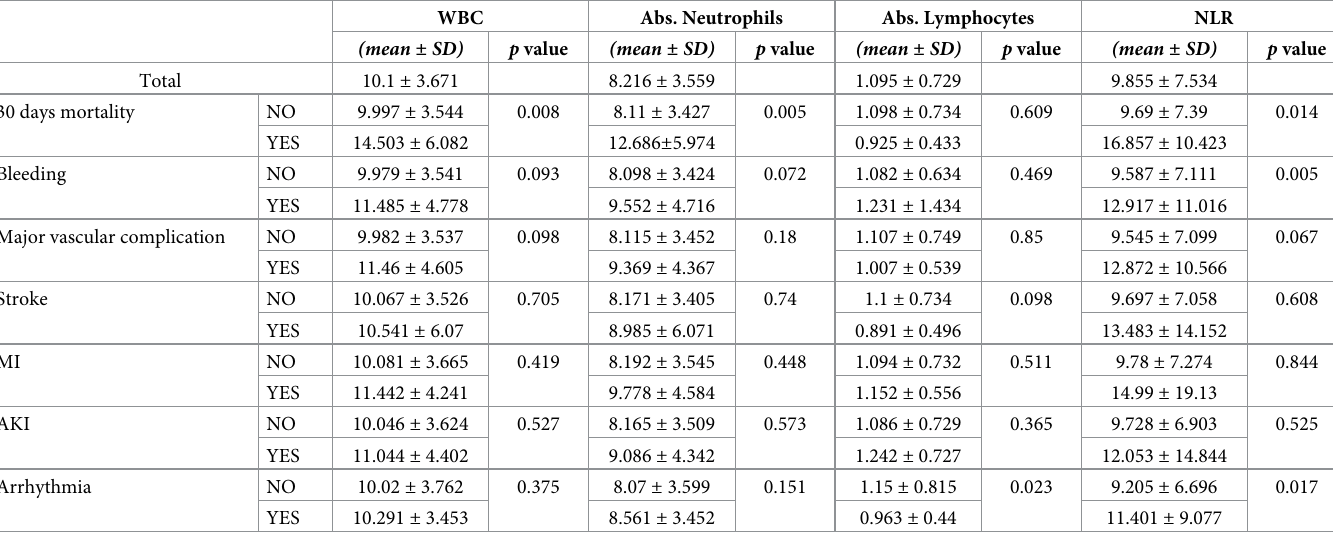
Table 4. Association of inflammatory markers at 24 hours and thirty days outcome in patient underwent TAVI ┼